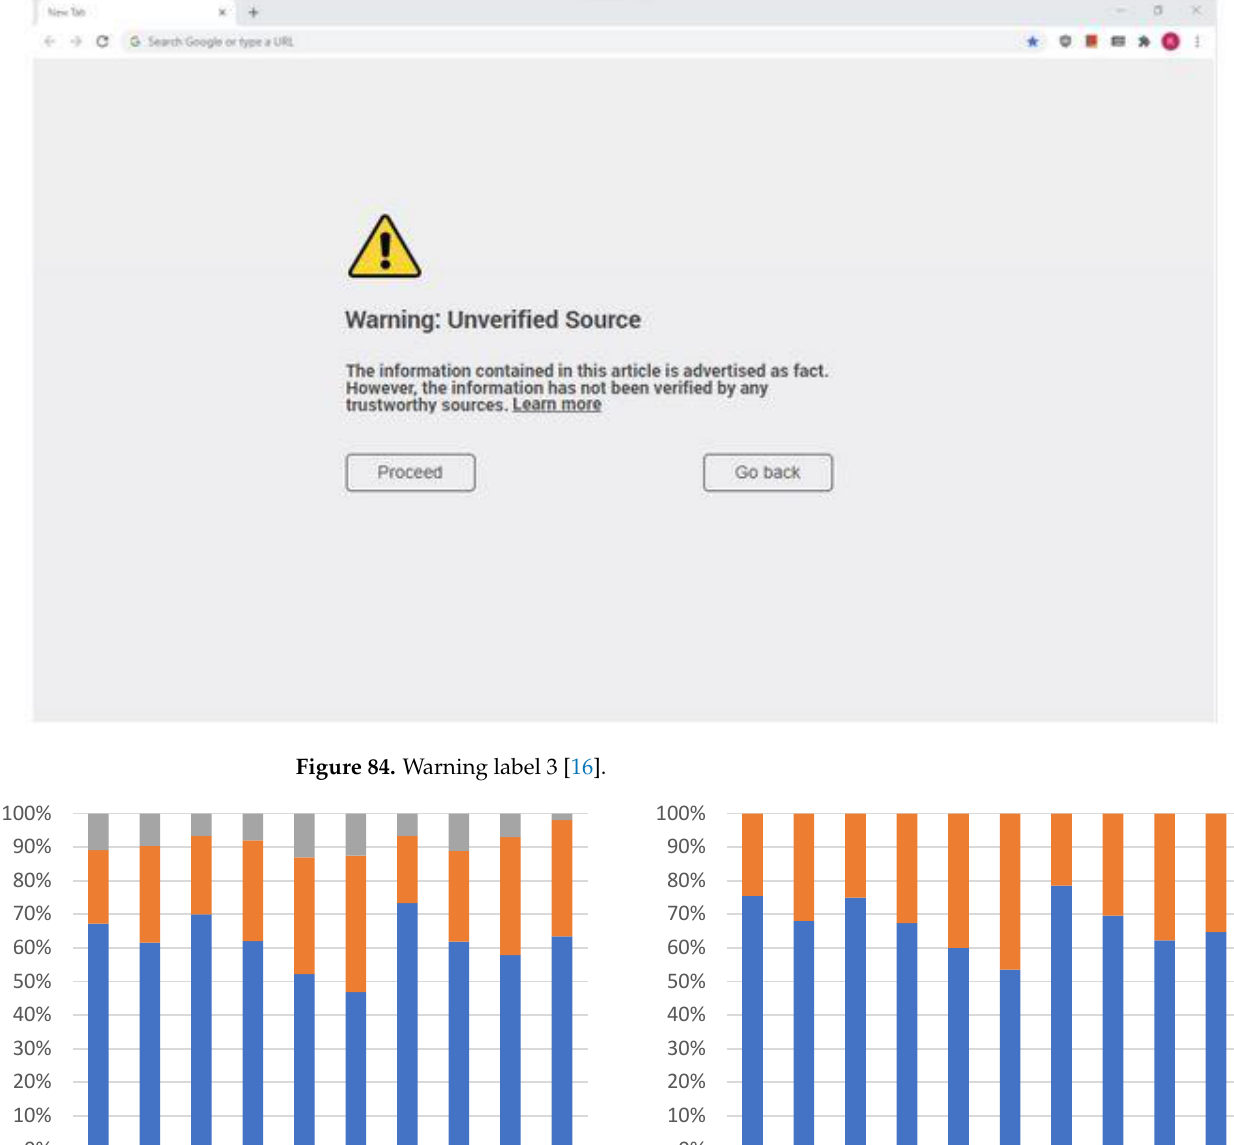
Figure 83. Label trustworthiness judging use, by gender: ( a ) with uncertain respondents (left) and ( b ) without uncertain respondents (right).